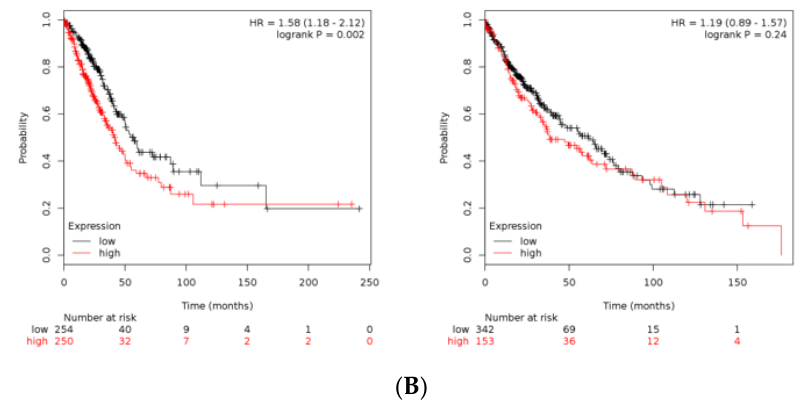
Figure 4. B4GALT1 gene expression and survival analysis in lung adenocarcinoma (LUAD) and lung squamous cell carcinoma (LUSC) patients. ( A ) On the left panel is shown a Box Plot of B4GALT1 expression in lung adenocarcinoma (LUAD) and lung squamous cell carcinoma (LUSC). Each dot represents a patient. (red: cancer tissues; grey: healthy tissues). On the right panel is shown a survival curves depict the B4GALT1 prognostic value in LUAD (N = 239 high expression tissues + 239 low expression tissues) and LUSC cohort (N = 241 high expression + 241 low expression). Comparison of survival curves was performed using a log-rank (Mantel–Cox) test. HR = Hazard ration. Dotted lines represent the 95% of Confidence Interval. ( B ) Kaplan–Meier curves depict the cumulative prognostic value of B4GALT1 and SCD1 gene expressions in LUAD (N = 250 high expression tissues + 254 low expression tissues) and LUSC (N = 153 high expression tissues + 342 low expression tissues) Abbreviations: LUAD, lung adenocarcinoma; LUSC lung squamous cell carcinoma; num, number; T, tumor; N, normal.